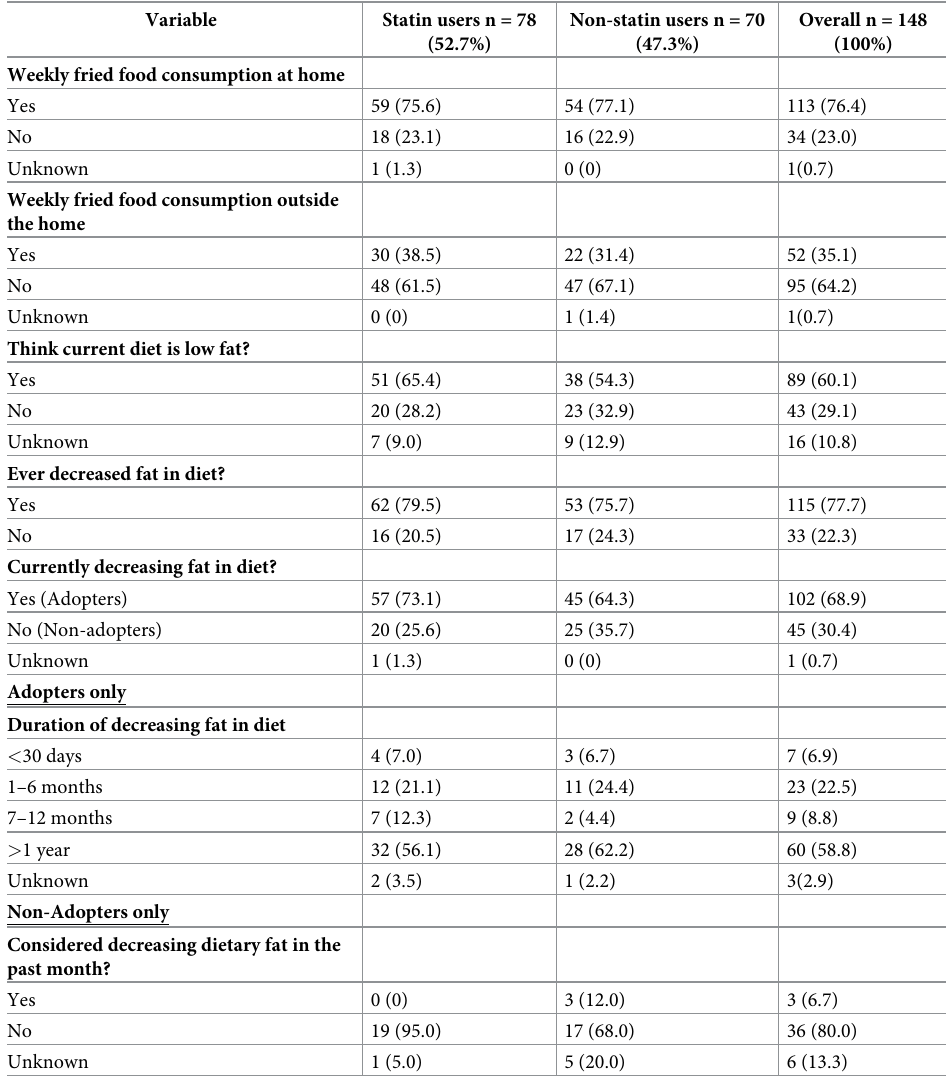
Table 2. Dietary patterns of quantitative study